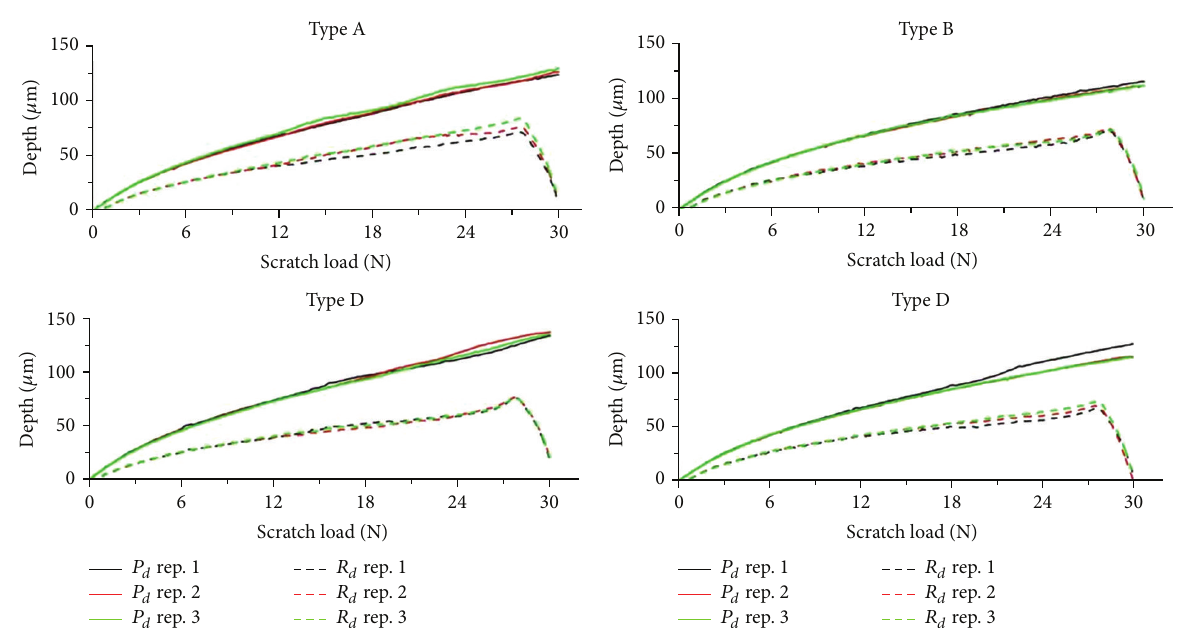
Figure 5: Penetration depth 𝑃 𝑑 and residual depth 𝑅 𝑑 in progressive mode scratch tests (Rep. 1, 2, and 3 are the three replications of the scratch tests performed on the different samples